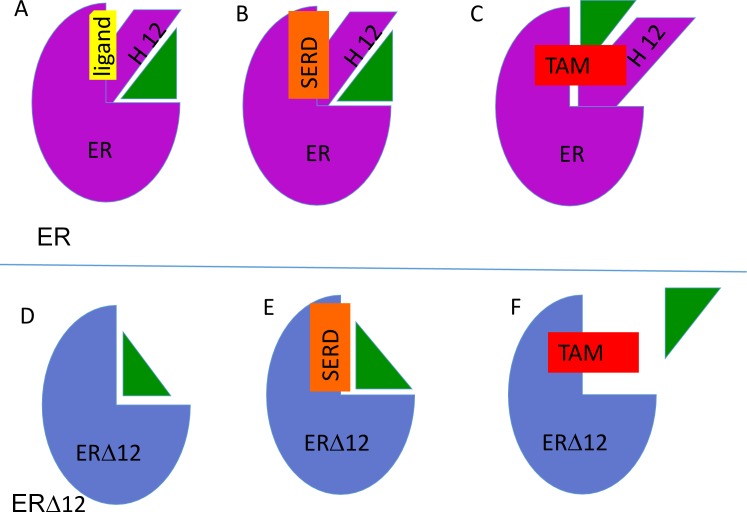
Model describing interaction between ER (purple) and ERX-11 (green) in presence of agonist (yellow) (A), SERD (orange) (B) or tamoxifen (red)(C).Note that in the presence of tamoxifen, ERX-11 binds to a secondary weaker affinity site on ER. Similarly, the interaction between ER▲12 (blue) and ERX-11 is modeled in the absence of agonist (D), SERD (E) or tamoxifen (F). Note that in the presence of tamoxifen, ERX-11 does not bind to a secondary site on ER▲12.